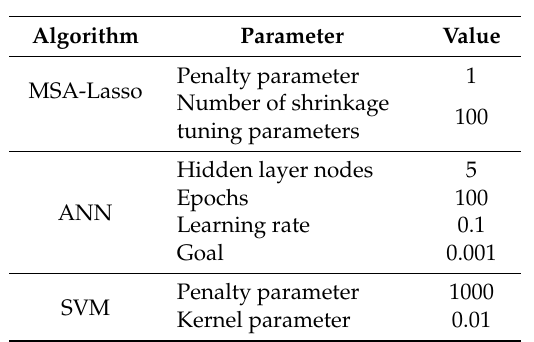
Table 4. Parameter settings of the three algorithms. MSA-Lasso: multi-step adaptive Lasso; ANN: artificial neural network; SVM: support vector machine.